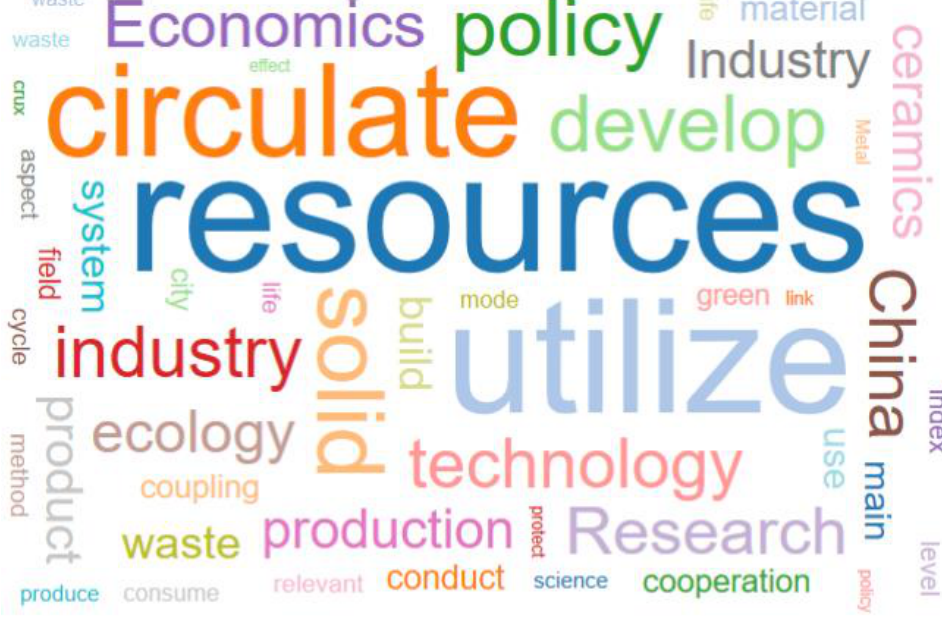
Figure 1. High-frequency word cloud.